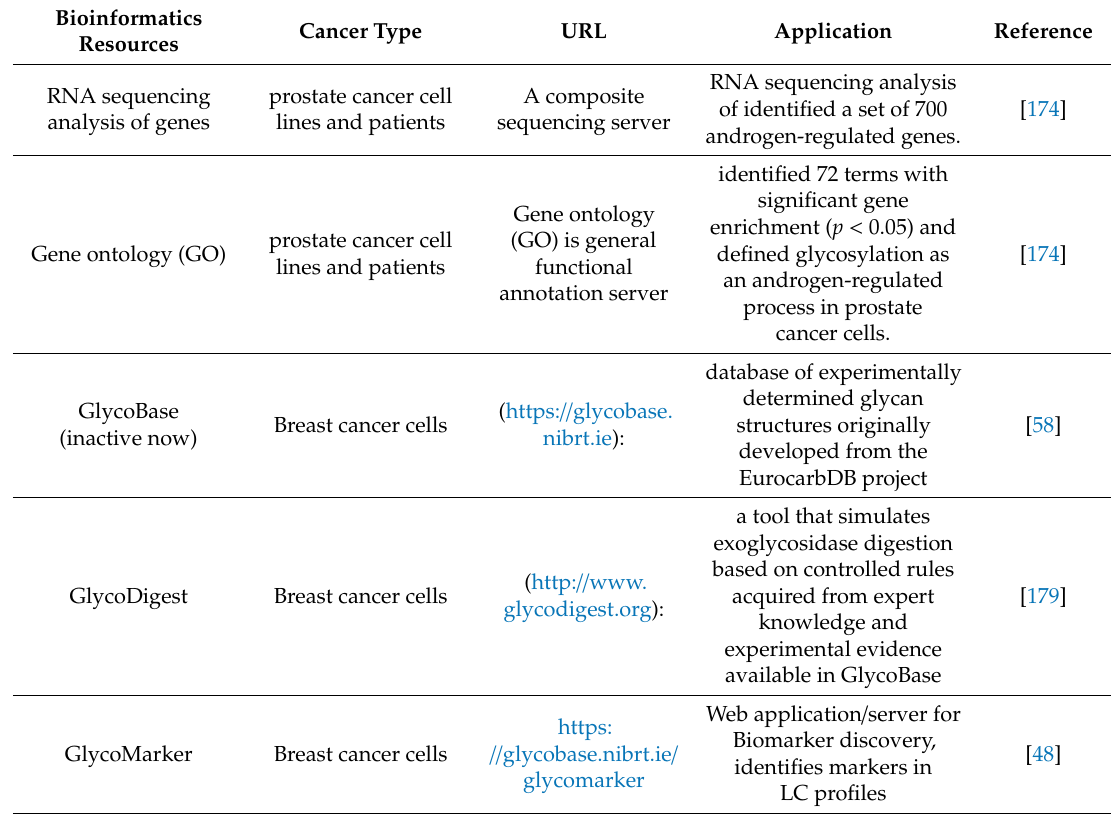
Table 2. Bioinformatic tools for glycosylation in cancer